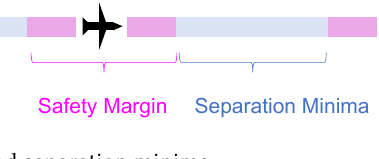
Figure 1. Safety margin and separation minima. Table 3. Inter-Aircraft Time Sigma (IAT Sigma) when applying different levels of automation